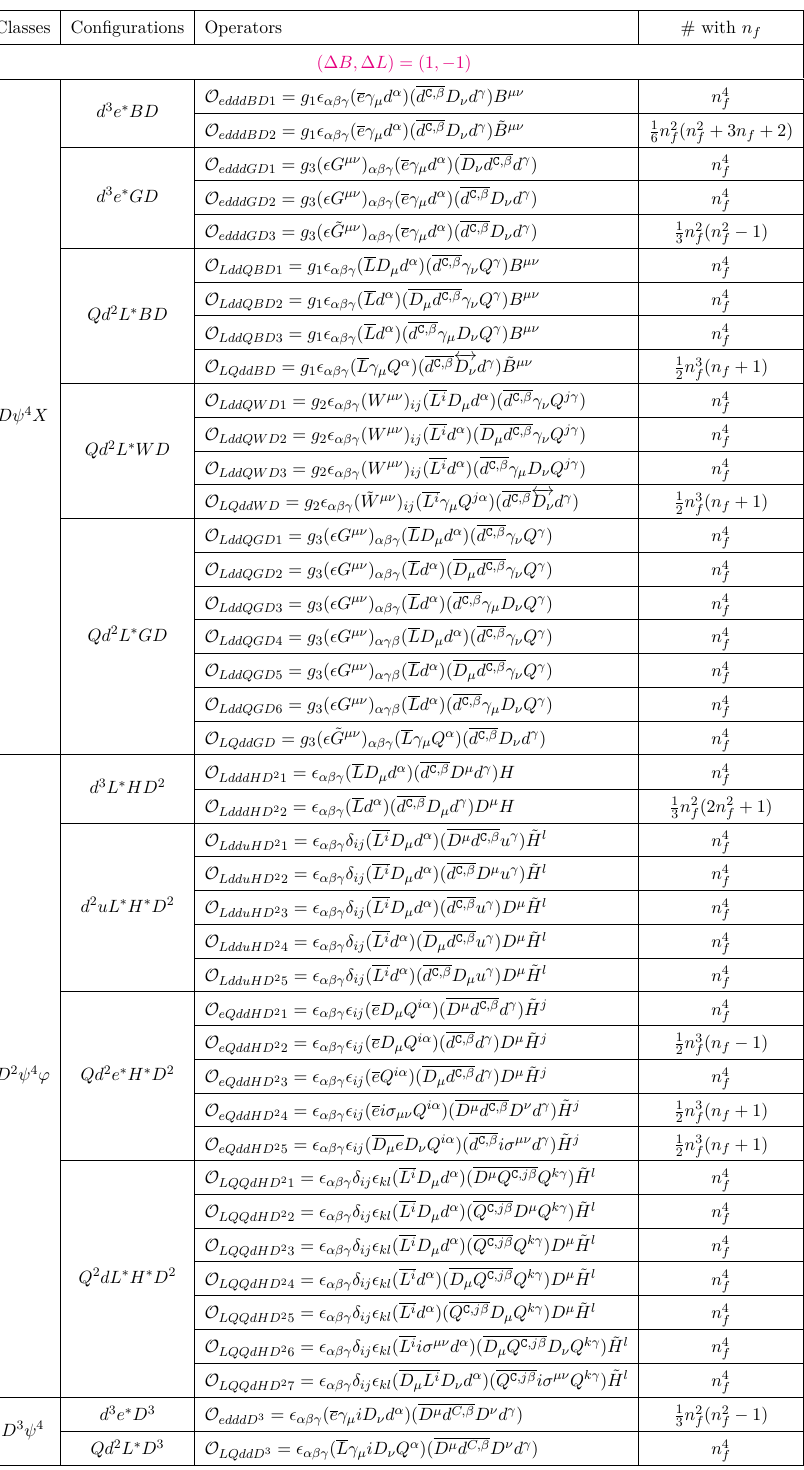
Table 9 . Dim-9 operators in classes Dψ 4 X, D 2 ψ 4 ϕ, D 3 ψ 4 for sector (∆ B, ∆ L ) = (1 , − 1) . There are 41 operators without counting fermion generations and 38 remain for one generation case. Hermitian conjugated operators are not included or